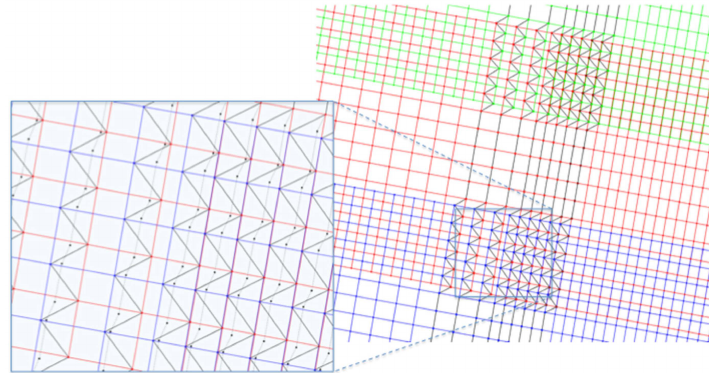
Figure 9. Geo-locations around the transition from the 2:1 to the 1:1 sample aggregation scheme. Unfolding order for this region corresponds to the N 5 +1:N 6 column of Figure 5c with only six middle detectors, 6 through 11, outside the bow-tie region. The insert on the left shows detailed overlap of the S k and S k+1 grids. Black zigzagging line represents reordered path and black dotted line corresponds to proposed grid with adjusted longitude